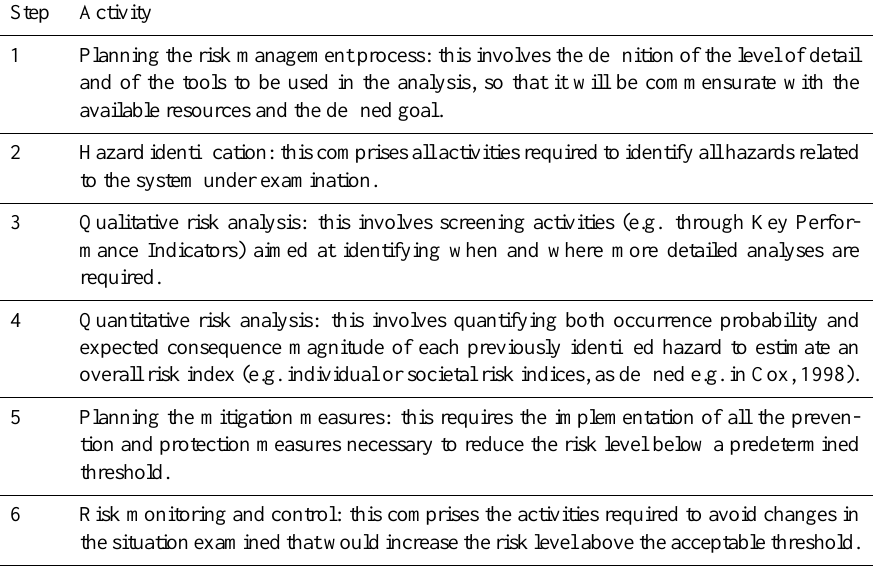
Table 1. Technical steps in the risk management process (Mannan, 2005; CCPS, 2000; Salzano and Cozzani,